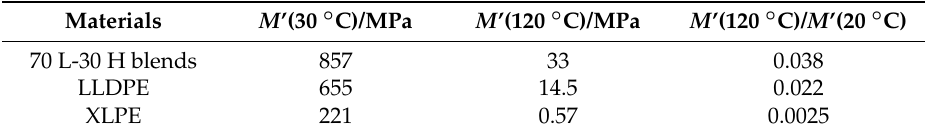
Table 1. Mechanical modulus of specific temperature points and their ratio.